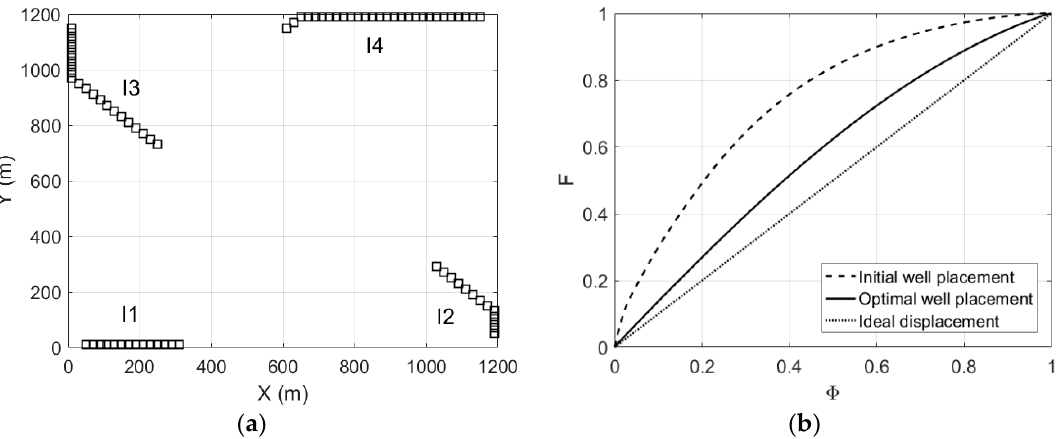
Figure 5. The results of the two-dimensional homogeneous aquifer test problem with random initial design parameters: ( a ) moving positions of the injection wells during the S/O iterations; ( b ) F ( Φ ) diagrams for the initial and optimal well positions.